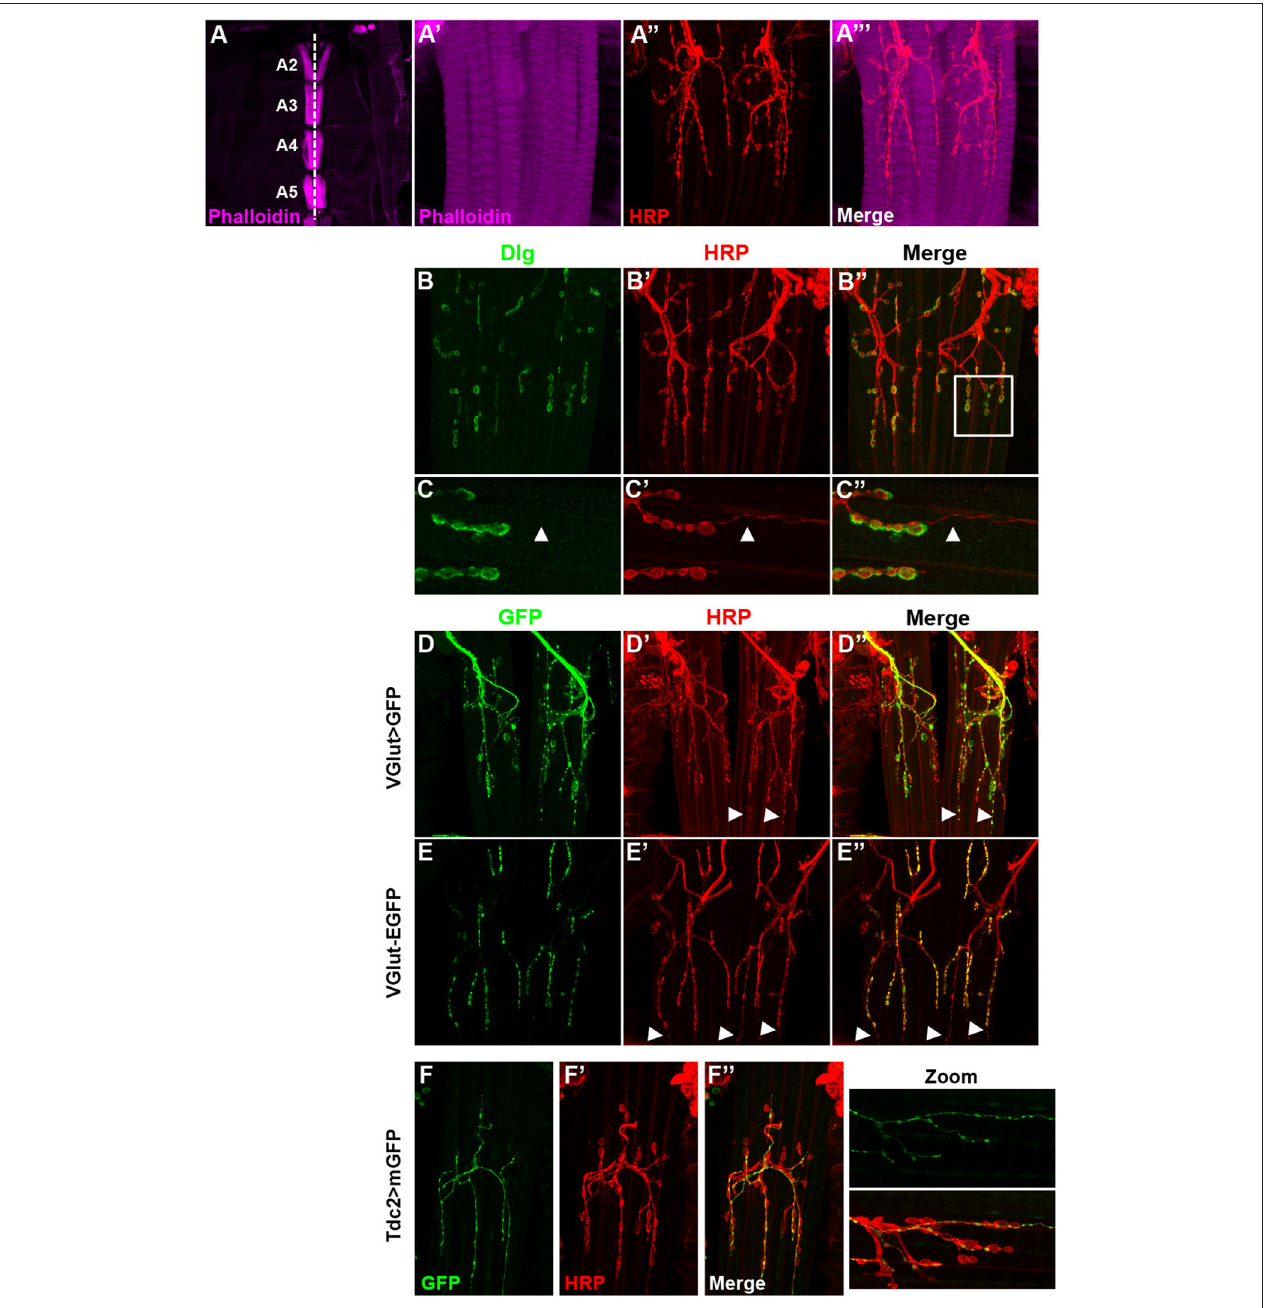
FIGURE 1 | The ventral abdominal muscles (VAMs) and their innervation in adult Drosophila . (A) In wild type flies, the VAMs are organized in a stereotyped pattern on the abdomen as observed at low magnification (from A2 to A5, 10X objective). Muscles are labeled using a phalloidin staining (F-actin, in magenta). The white dotted line represents the ventral midline. (A’–A”’) At higher magnification (63X objective) motor neurons (HRP staining in red) innervate each muscle fiber and synaptic boutons are visible. (B–B”) Discs large (Dlg, in green) is expressed at the post-synaptic level and surrounds the synaptic boutons (HRP labeled, in red). (C–C”) Zoom images of region outlined (white box in B” ) show that Dlg (C) is not associated with the smaller boutons ( C’ , white arrowheads). In all presented images the anterior side is up. (D–D”) The VAMs are innervated by glutamatergic motors neurons. The VGlut Gal4 line drives the expression of the GFP in motor neurons and synaptic boutons of the VAMs. White arrowheads show the expression of GFP in small varicosities. (E–E”) The EGFP tagged VGlut construct labels all the synaptic boutons. The VGlut protein trap expression is very low in the smaller varicosities (white arrowheads). (F–F”) The VAMs receive also octopaminergic/tyraminergic innervation. (F) The Tdc2 Gal4 line allows the GFP expression exclusively in the smallest population of boutons (see merge in F” ). This octopaminergic/tyraminergic innervation is closely associated to glutamatergic boutons as showed in zoomed images. For all conditions, motor neurons are stained with HRP (Horse Radish Peroxidase is a neuronal membrane marker, Jan and Jan, 1982), images of abdominal segments A3–A5 are represented.